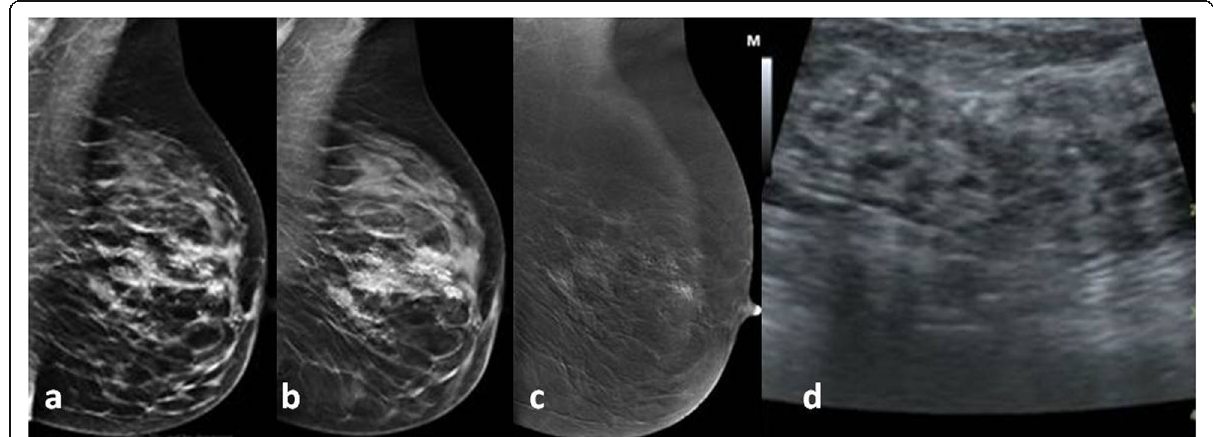
Fig. 1 A 32-year-old patient with a history of left breast ductectomy. She presented by mastalgia and a palpable mass in the left breast. Mammography and DBT revealed clusters of pleomorphic microcalcifications in the left upper outer quadrant ( a , b ). CEM showed faint heterogeneous segmental non-mass enhancement in the left upper outer quadrant ( c ). Breast ultrasound showed microcalcifications with no associated mass lesions ( d ). The final diagnosis was invasive ductal carcinoma with